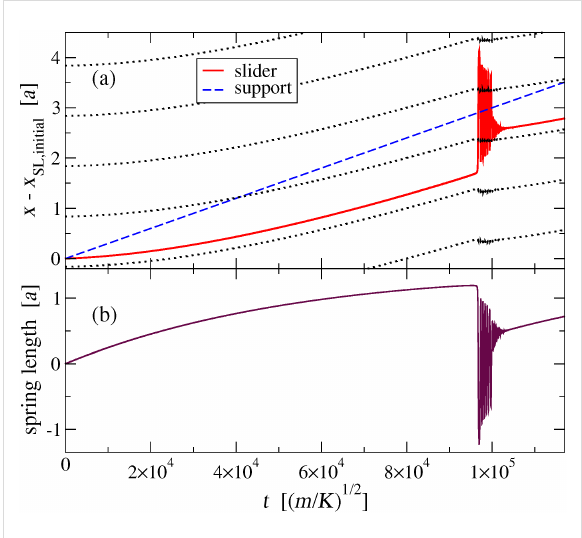
Figure 14: (a): The motion of the slider (solid line) as it is pulled by a spring having elastic constant K pull = 10 − 3 K connecting it to a support (dashed line) advancing at a constant speed v pull = 3 × 10 − 5 v s ; the dotted lines mark the time evolution of the positions x j of successive atoms in the chain. (b): The pulling spring length as a function of time: the spring elongates until the slider suddenly slips forward, oscillates around the next stick position, and dissipates the energy accumulated in the pulling spring by emitting phonons. The process then repeats itself.